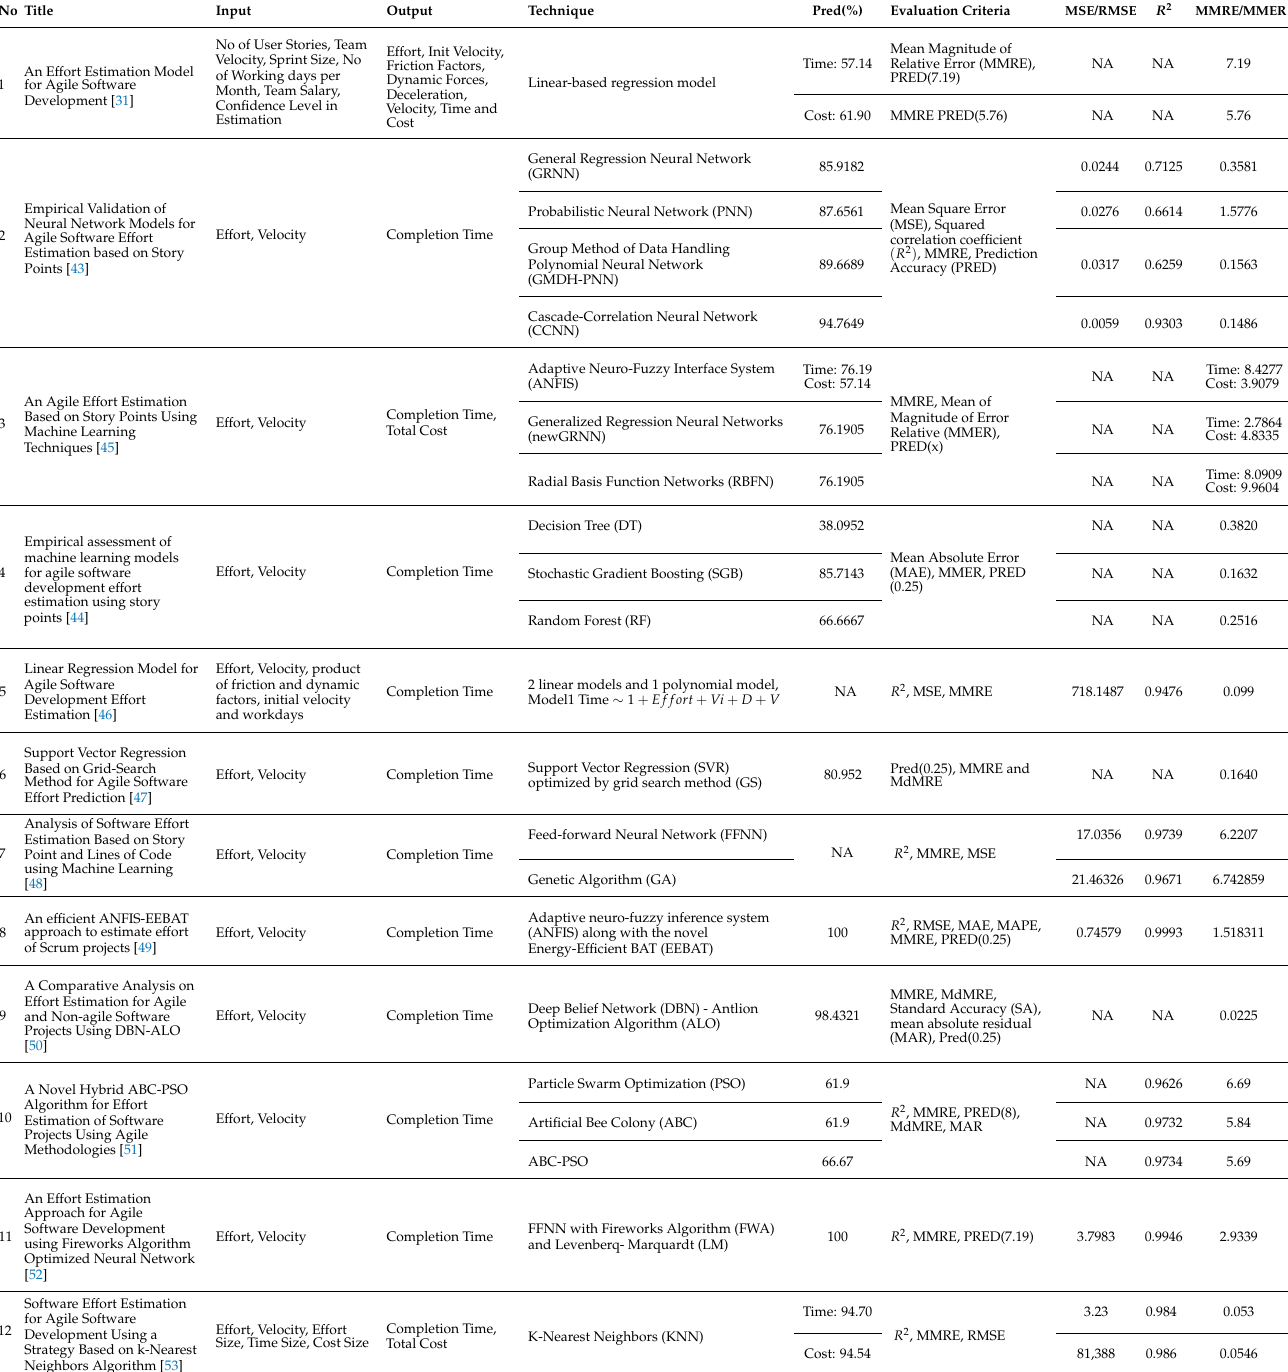
Table 1. Extending Table 1 from [54], we summarize the studies that train the algorithms using Zia et al. [31]